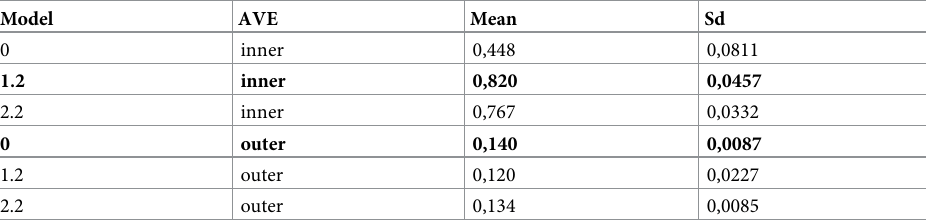
Table 3. Bootstrapped mean and standard deviation of inner and outer AVE values on the pouchitis